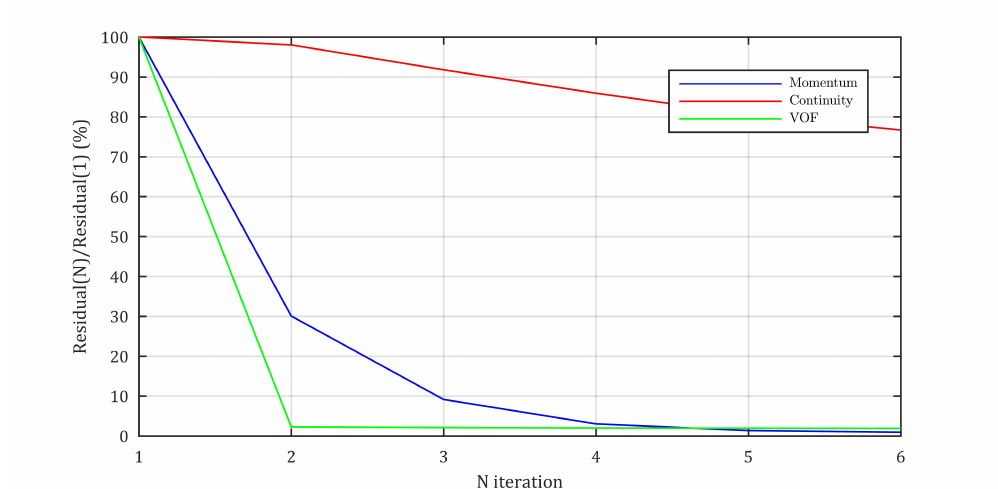
Figure 8. Residual drop along iterative steps, for the u velocity component momentum equation, the mass balance equation and the VOF scalar transport equation.